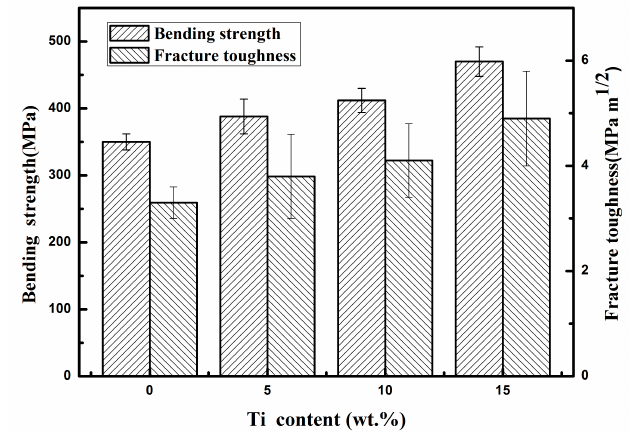
Figure 4. Vickers hardness values of the composites infiltrated by the Al–Si–xTi alloy (Si: 10 wt.%).